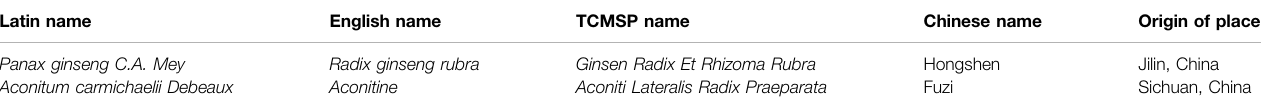
TABLE 1 | Information of Shenfu injection.